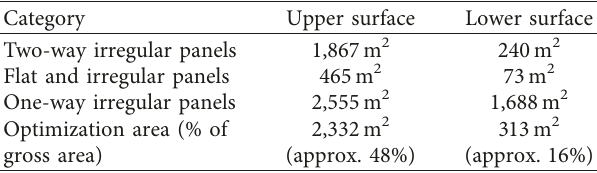
Table 1: Panel optimization of upper and lower